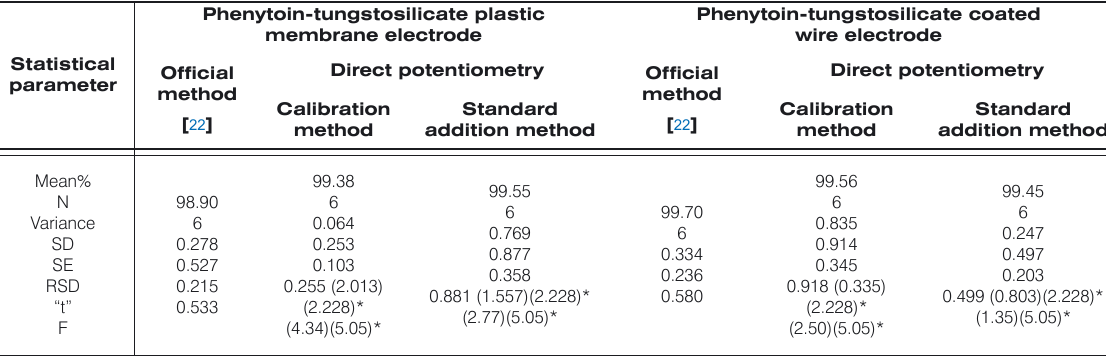
Table 4. Determination of phenytoin sodium in pure form using phenytoin-tungstosilicate sensors in comparison with official method [ 21